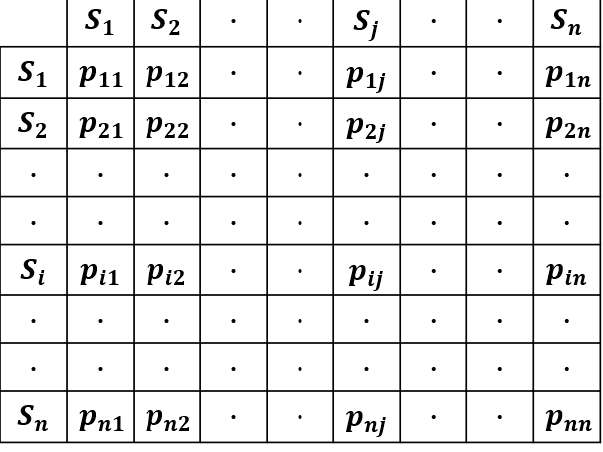
Figure 5. General 𝑛 × 𝑛 MTM. Figure 5. General n × n